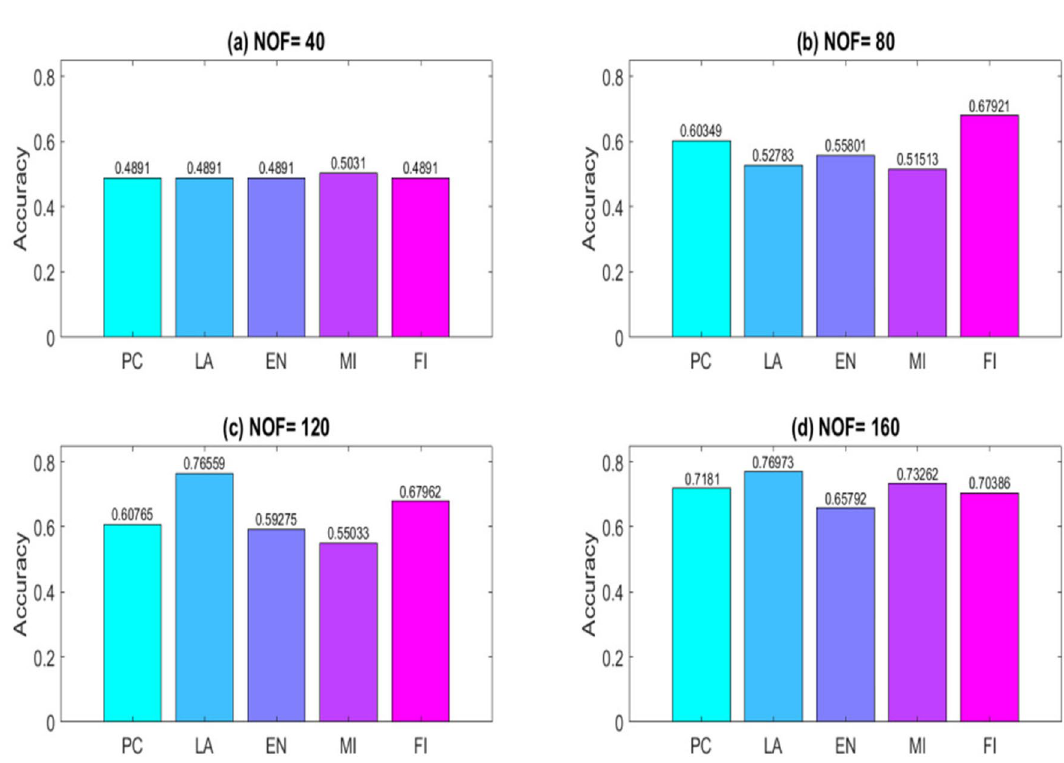
Figure 15. Outcomes of the filter FS methods on the Arrhythmia dataset with selecting ( a ) 400, ( b ) 800, ( c ) 120, and ( d ) 160 features. The results of the methods differ from each other with a various number of features. PC, Pearson correlation; LA, Laplacian score; EN, entropy; MI, mutual information; FI, Fisher